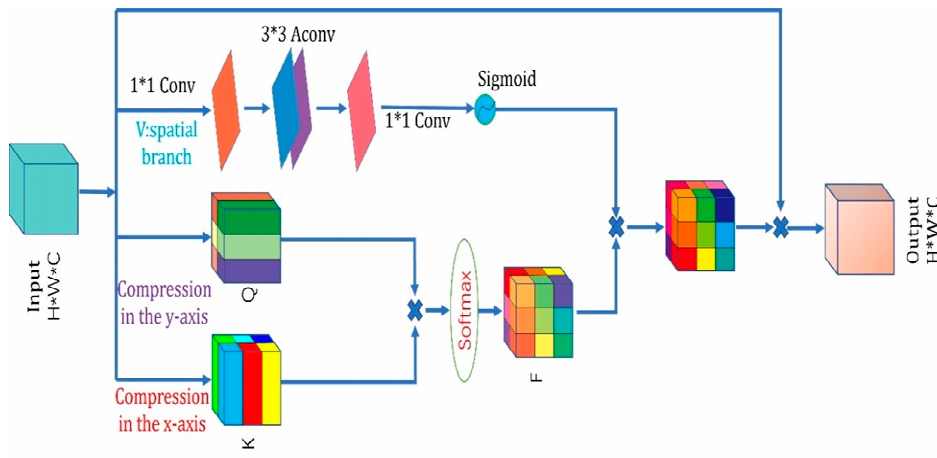
Figure 3. The structure of the Axial self-attention block. F ij is the feature weight value of the i th row and j th column. Function f calculates their